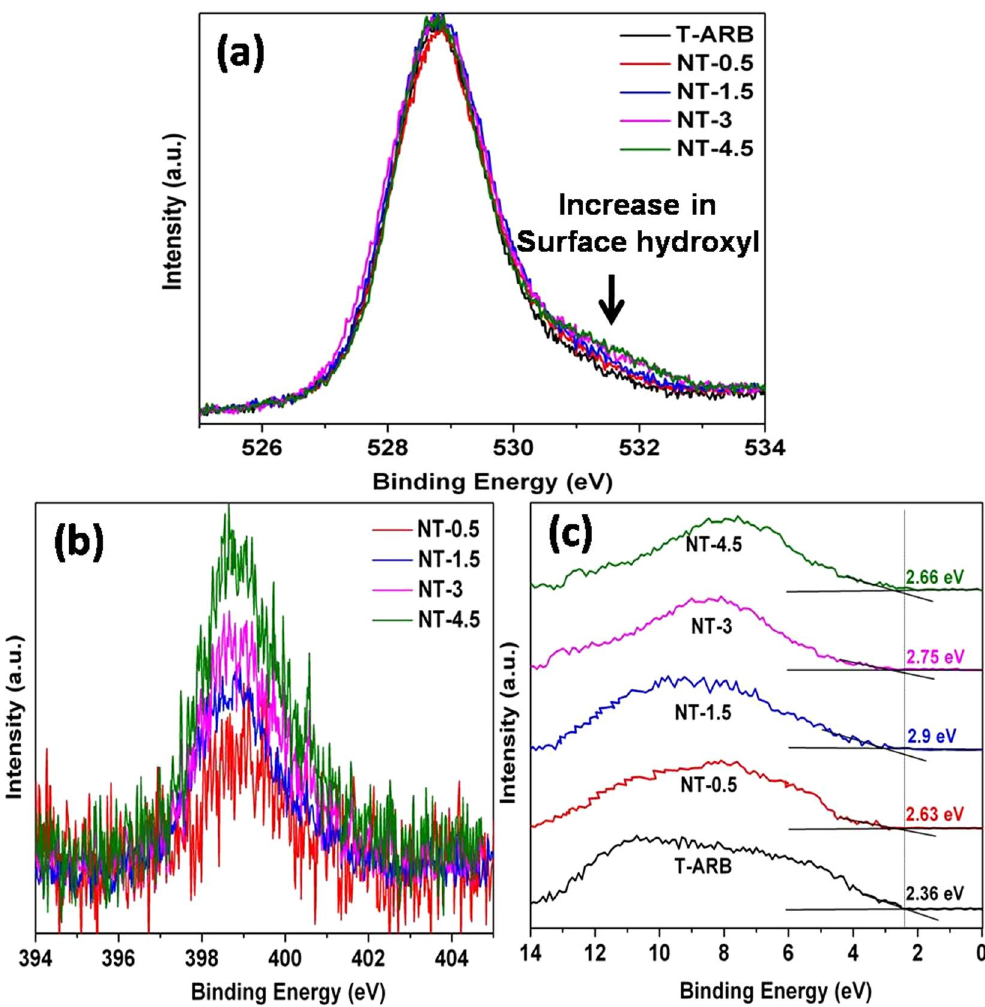
Figure 9. ( a ) O 1 s spectra, ( b ) N 1s spectra and ( c ) UPS analysis of pristine and N doped